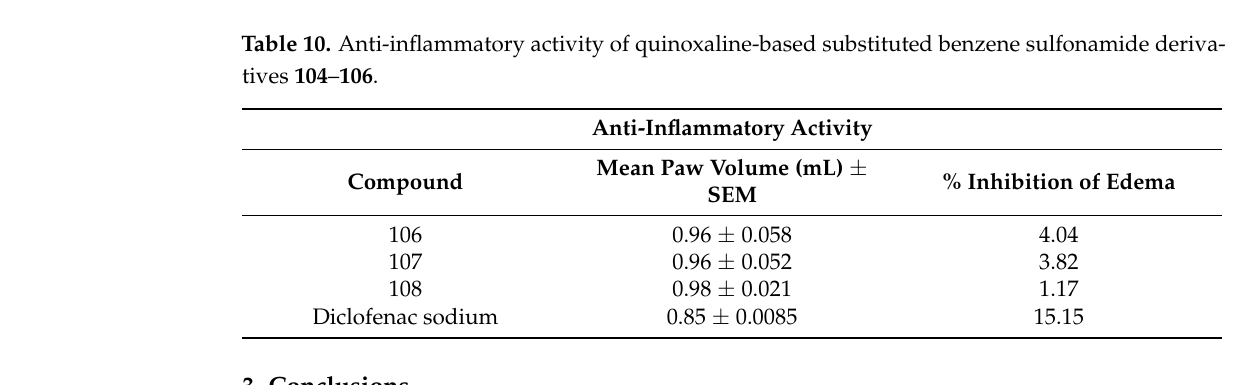
Table 10. Anti-inflammatory activity of quinoxaline-based substituted benzene sulfonamide deriva-